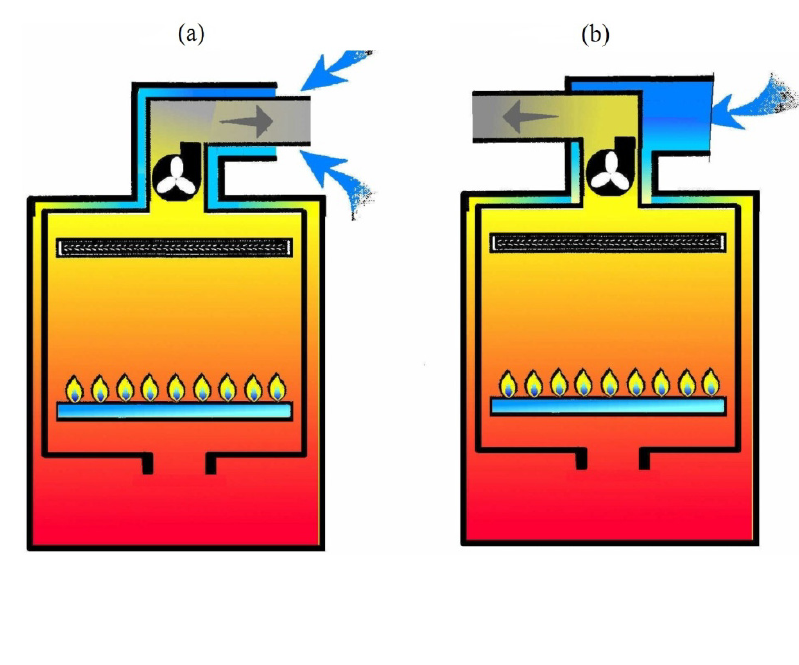
Figure 1. Basic types of chimney and air supply ducts: ( a )—concentric system; ( b )—separate